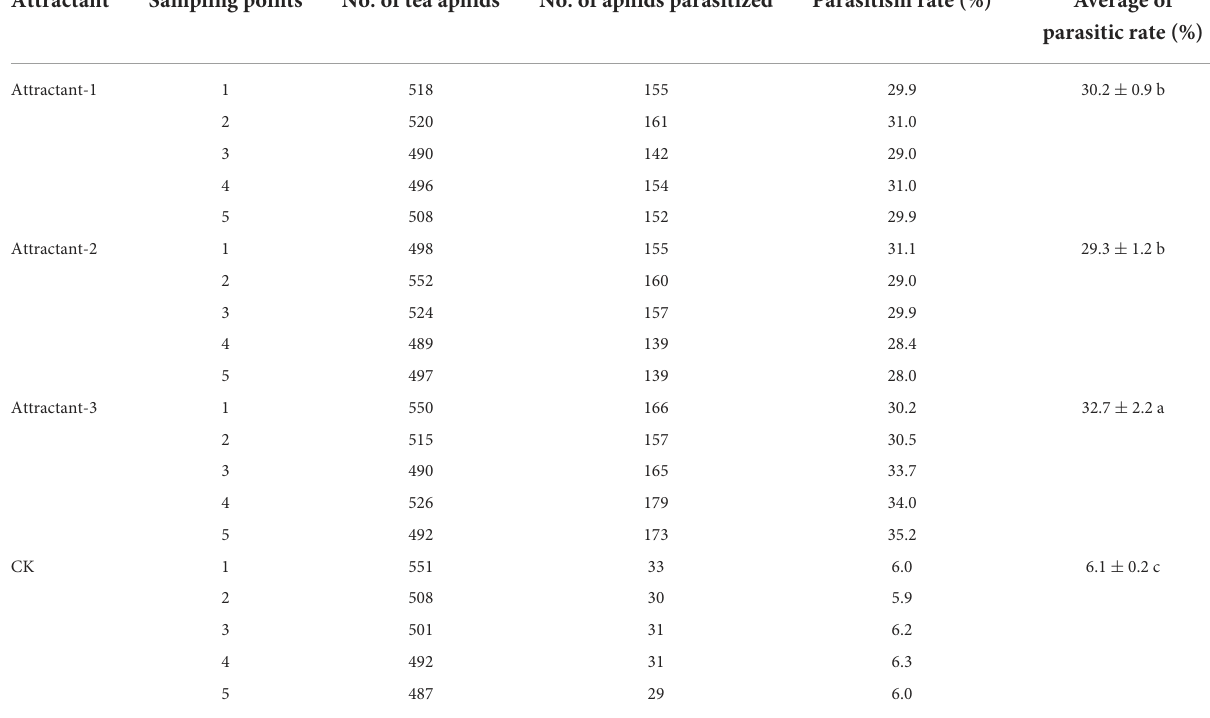
Fieldsite:MeijiawuVillageofHangzhouCityinZhejiangProvinceofChina. Themeanparasitismratedatawithdifferentlettersweresignificantlydifferentatp < 0.05.